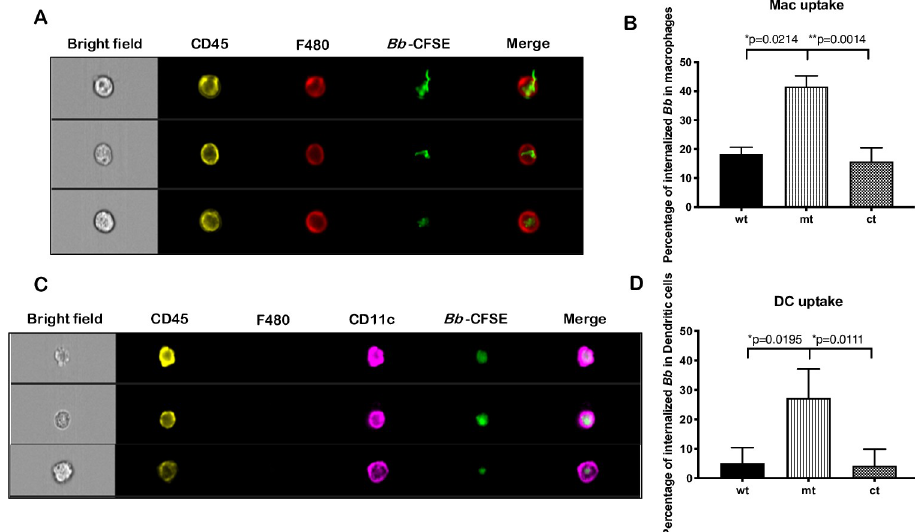
Fig 14. Phagocytosis of bpiP mt by activated macrophages and dendritic cells. All three strains (wt, mt and ct) were labeled with CFSE dye as described in the Materials and Methods sections and incubated with activated macrophages or dendritic cells for 10 mins. The infected cells were then harvested and stained for macrophage positive markers CD45 and F4/80 using antibodies conjugated to the fluorophores PE and APC respectively. Macrophages were identified as CD45 + (Ex (max)/ Em (max) : 565/578; channel 3) /F480 + (Ex (max)/ Em (max) : 652/660; channel 11) cells while DC were identified as CD45 + /CD11c + (conjugated to the flurophore BV421, Ex (max)/ Em (max) : 495/520; channel 7) but F480 negative cells. The samples were analyzed by Image Flow Cytometry with (A) macrophage markers detected using channels 3 and 11 corresponding to excitation wavelengths of 488nm and 642 nm, respectively and (C) DC markers were detected using channel 7 with an excitation wavelength of 405nm. CFSE-labeled Bb was detected using channel 2 ( Bb /CFSE Ex (max)/ Em (max) : 495/520) with an excitation wavelength of 488nm. Data shown are means of three technical replicates with error bars representing Standard Error Mean. Pictures are representative of data obtained from one of three independent experiments. The percentage of internalized Bb within (B) macrophages and (D) dendritic cells was quantified and analyzed statistically using unpaired t test. The asterisks indicate levels of significance as follows: �� , p < 0.01; � , p < 0.05.